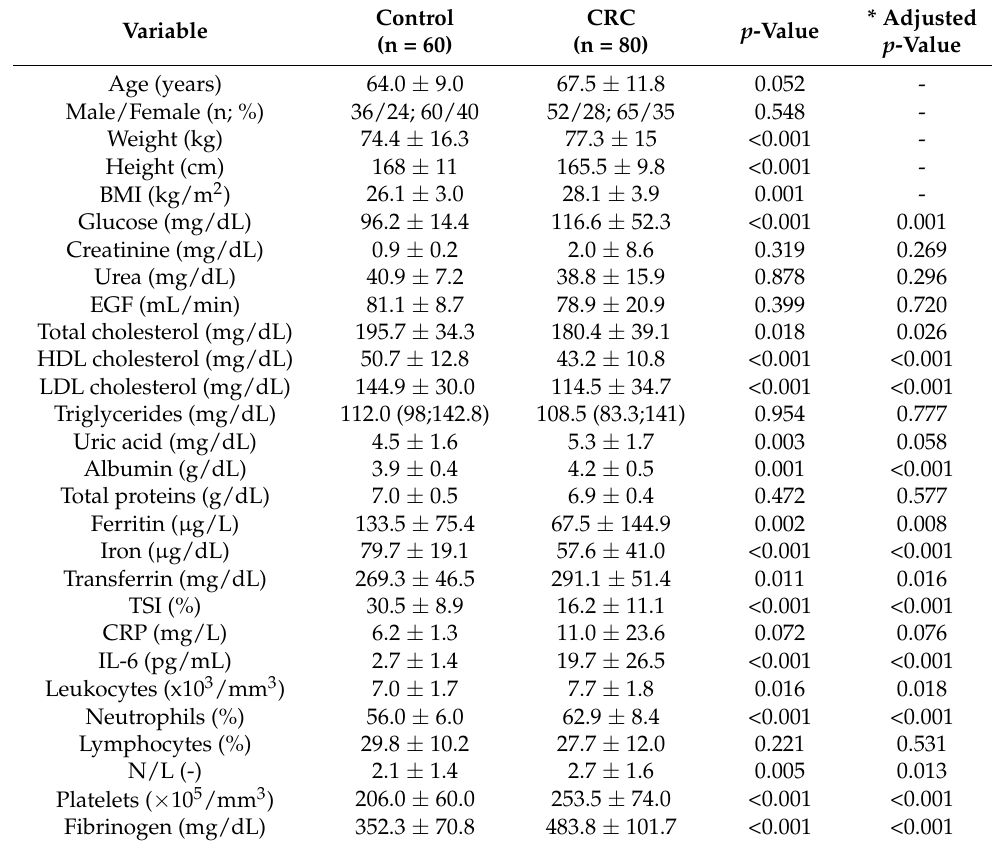
Table 1. Demographic, anthropometric, biochemical, and hematological parameters of controls and colorectal cancer (CRC)